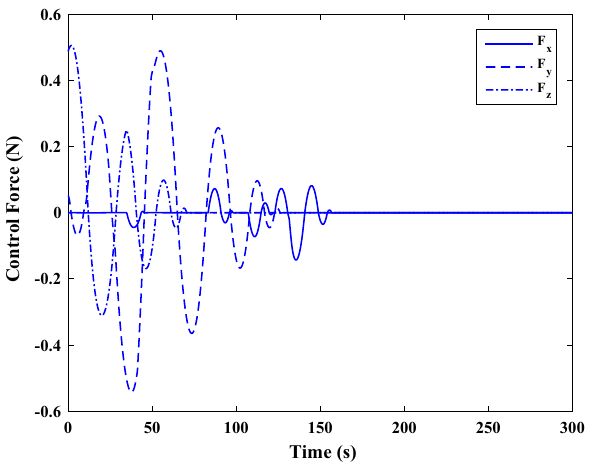
Figure 28. Scenario I: chaser control force.